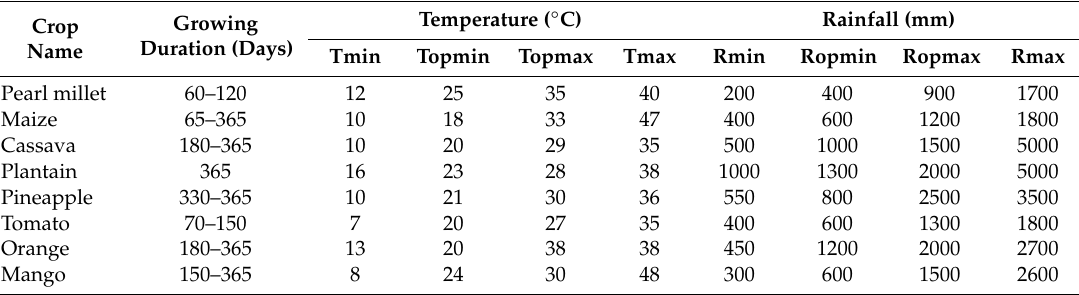
Table 2. Crop growth thresholds for eight crops as generated by the Ecocrop